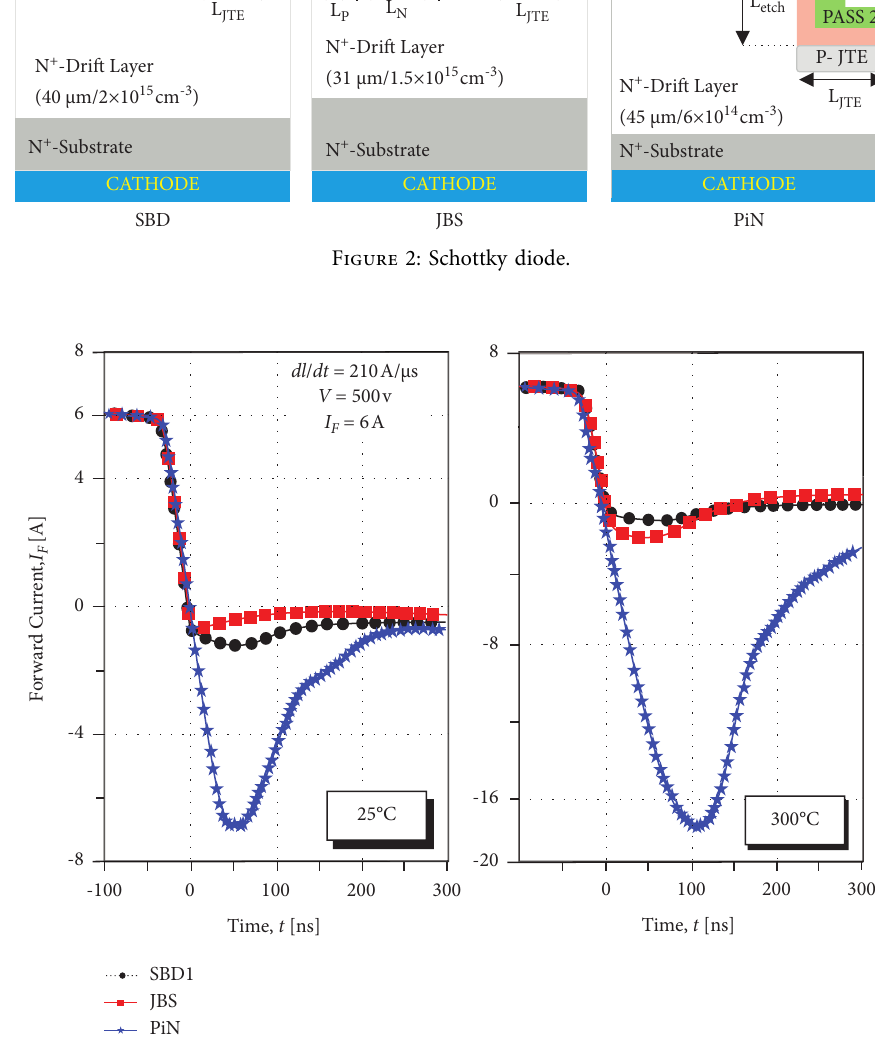
Figure 3: Inductive load turn